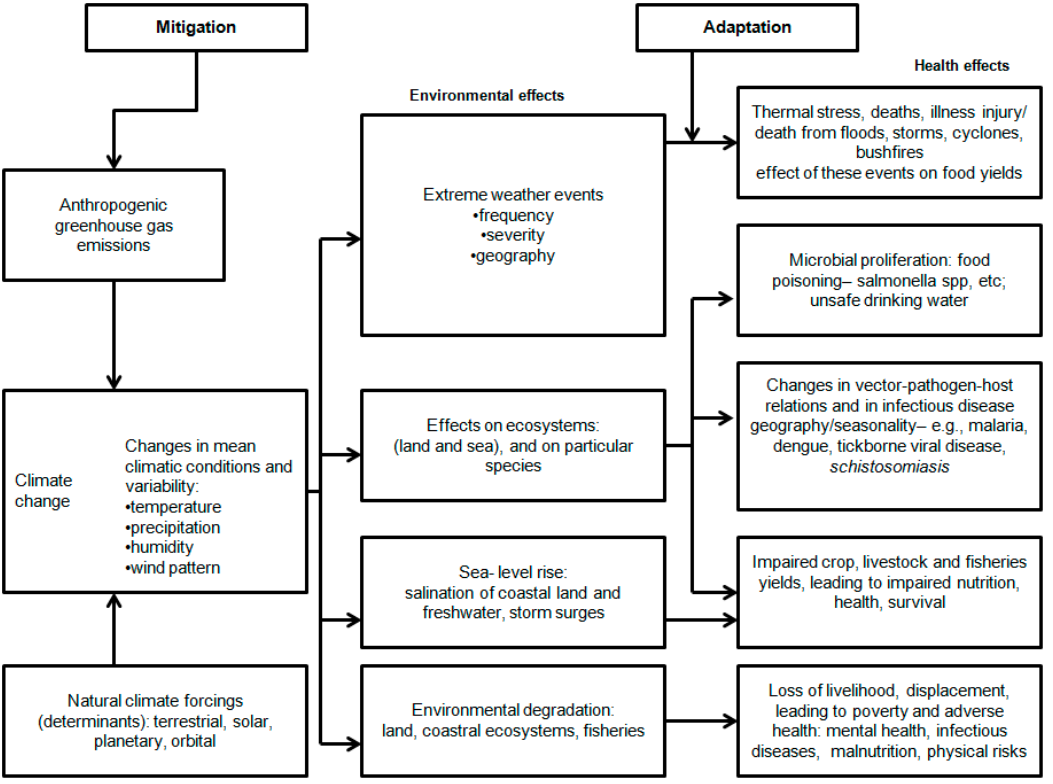
Figure 1. Overview of environmental and health effects linked to mitigation and adaptation strategies to climate change (after [5]).